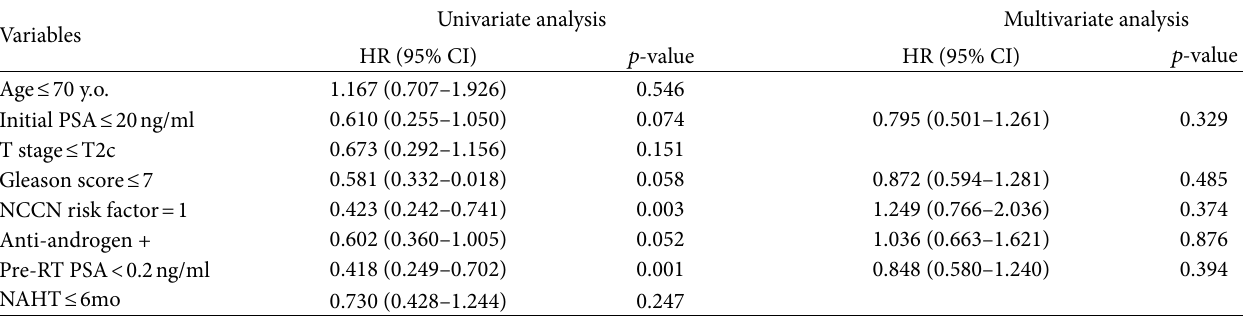
Table 2: Multivariate analysis of factors affecting PSA recurrence-free survival.